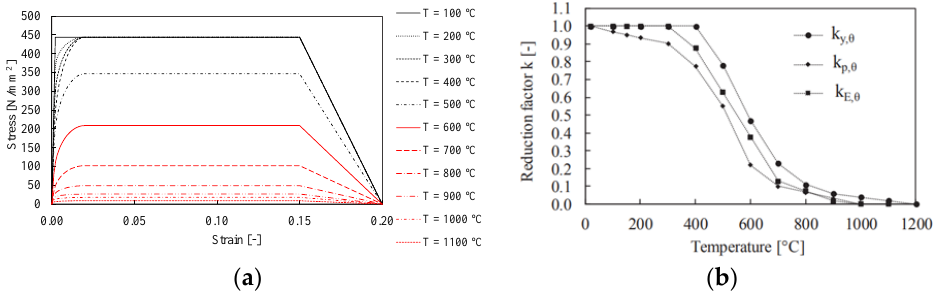
Figure 5. Stress–strain curves ( a ) and relevant reduction factors ( b ) at elevated temperatures.